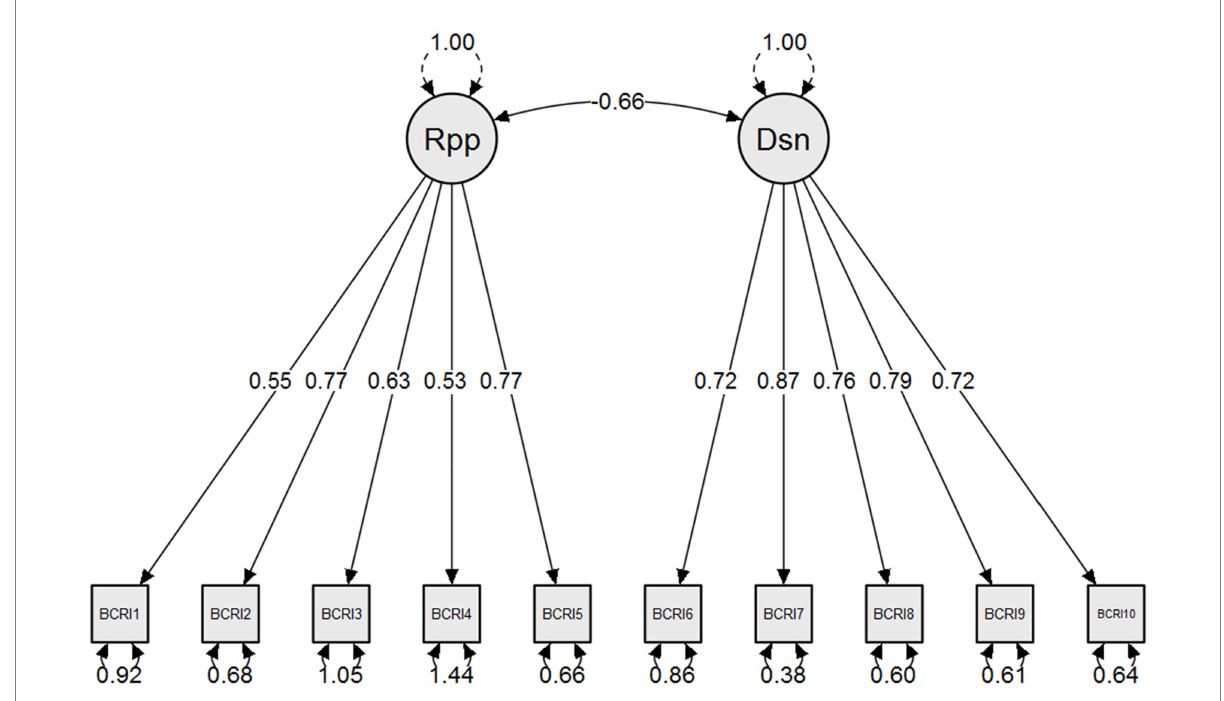
FIGURE 1 Standardized model parameters for the confirmatory factor analysis: two-factor model. Rpp, reappraisal; Dsn,